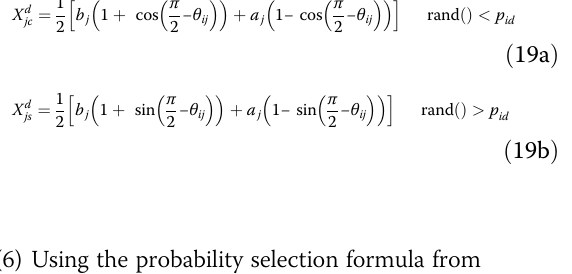
(6) Using the probability selection formula from fireworks, explosive sparks and Gaussian variant spark population p ( x i ) selects N individuals as fireworks for next-generation iteration